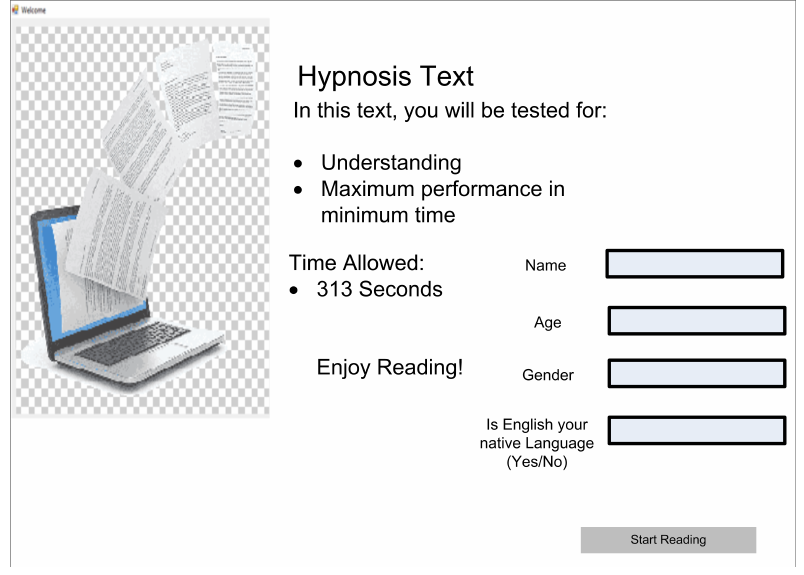
Figure 1. Initial Graphic User Interface (GUI).